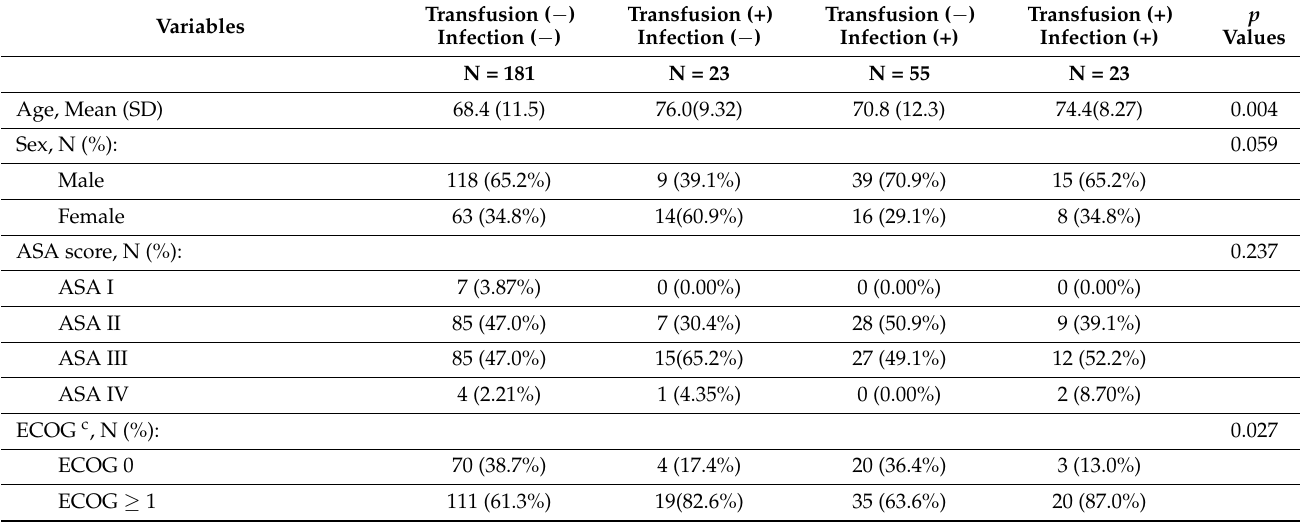
Table 1. Demographics, comorbidities; analytical, surgical, and pathology characteristics in the study population, classified in four groups depending on their perioperative